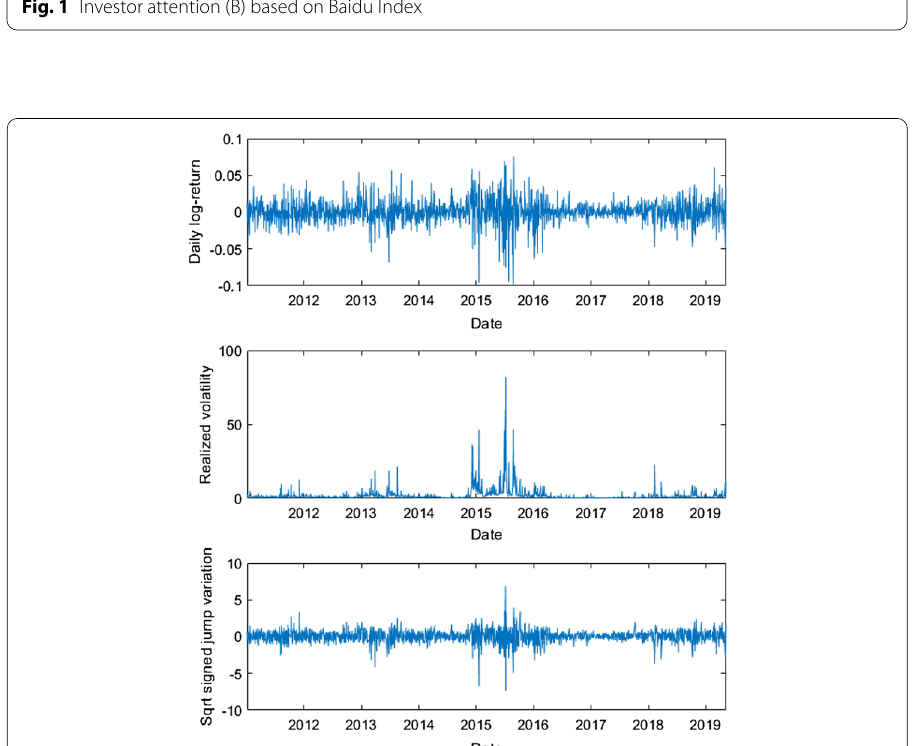
Fig. 2 Log-returns (top panel), realized volatility (middle panel) and sqrt root of signed jump (bottom panel) of SSE 50 over the period. We square the absolute value of signed jumps and keep the sign to reduce the data